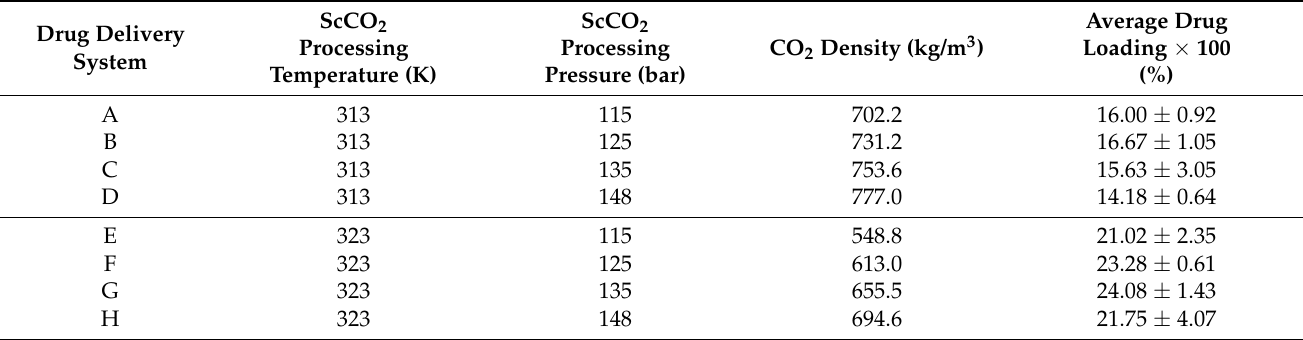
Table 1. Sample parameters used in drug release